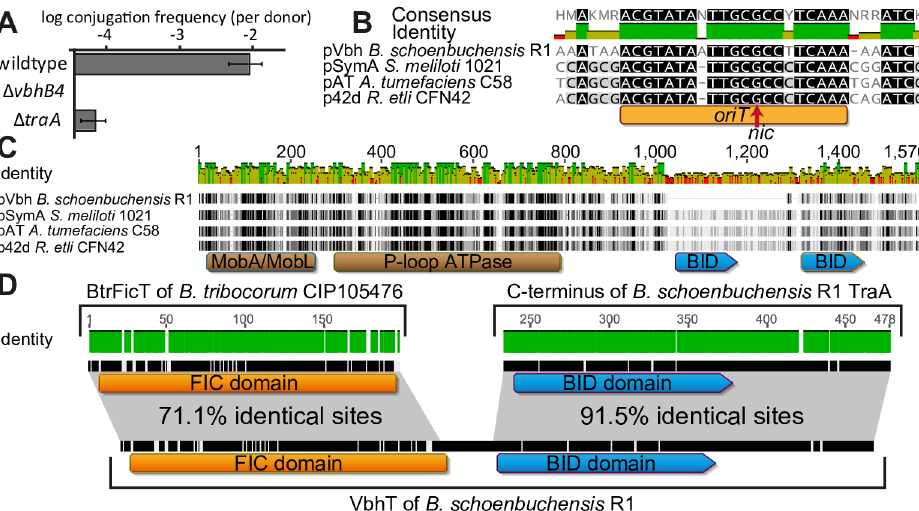
Fig 4. pVbh as a conjugative replicon with composite toxin VbhT. (A) Filter matings of B . schoenbuchensis R1 donorsand B . henselae recipients revealedthat pVbhconjugatesat a frequencyof ca. 1% per donor. Conjugative transferdependedon a functional Vbh T4SS ( vbhB4 mutant) and its Dtr functions( traA mutant). Data pointsand error bars represent meanand standarddeviationof at least three independent experiments. (B) The originof conjugativeDNA transfer ( oriT ,orangebar) on pVbhwas inferredby comparisonto closely relatedrhizobial plasmidswherethis sequence and the actualsite of relaxasecleavage( nic )had been experimentally determined [16].All these plasmidsinvariably encode oriT betweenthe traA relaxaseand the traCD relaxasomecomponentsin the dtr region(see Fig 2).(C) Domaincompositionand sequencealignment of the TraA relaxaseof pVbhwith relaxasesof closelyrelatedrhizobial conjugationsystems. (D) The alignment of BtrFicT, VbhT, and TraA proteinsequencesshowsthat VbhT is a compositeproteinwith an N-terminalFIC domaincloselyrelatedto FicT toxins of Bartonella and a C-terminalsecretionsignalvirtuallyidenticalto homologous sequenceof the TraA relaxase.